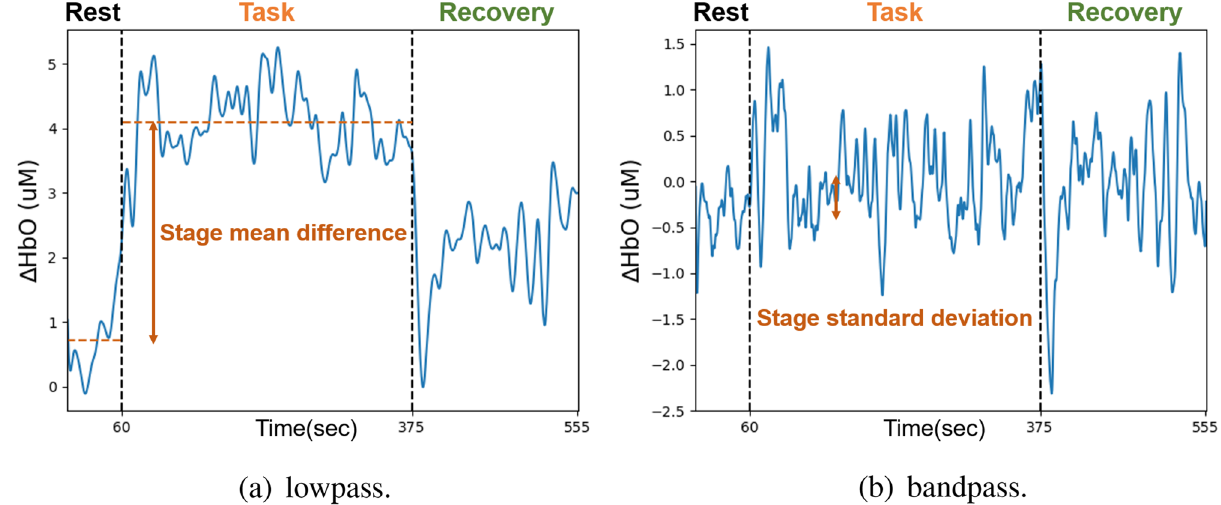
Figure 1. fNIRS signals during the MAT after ( a ) lowpass ( b ) bandpass filtering. This results are from one of the migraine subjects.